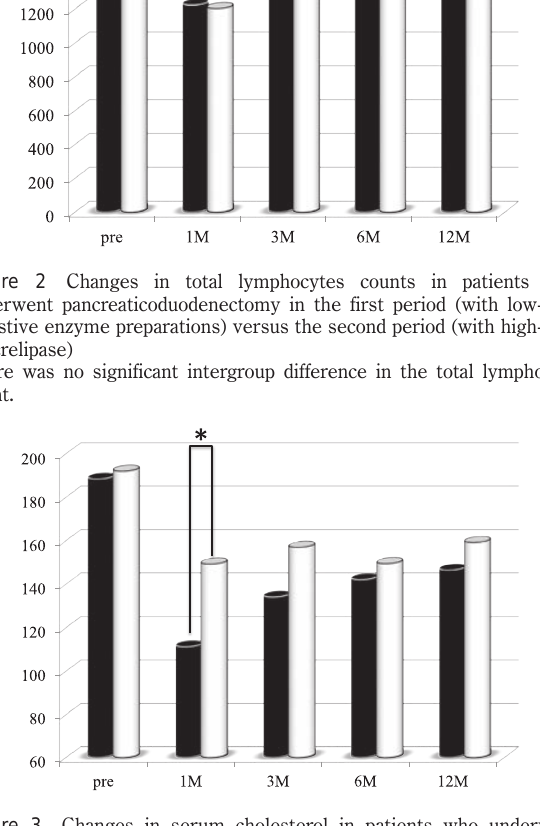
Figure 3 Changes in serum cholesterol in patients who underwent pancreaticoduodenectomy in the first period (with low-titer digestive enzyme preparations) versus the second period (with high-titer pancrelipase) The serum total cholesterol concentrations at 1 month postoperatively were significantly higher in the second period group (white bar) than in the first period group (black